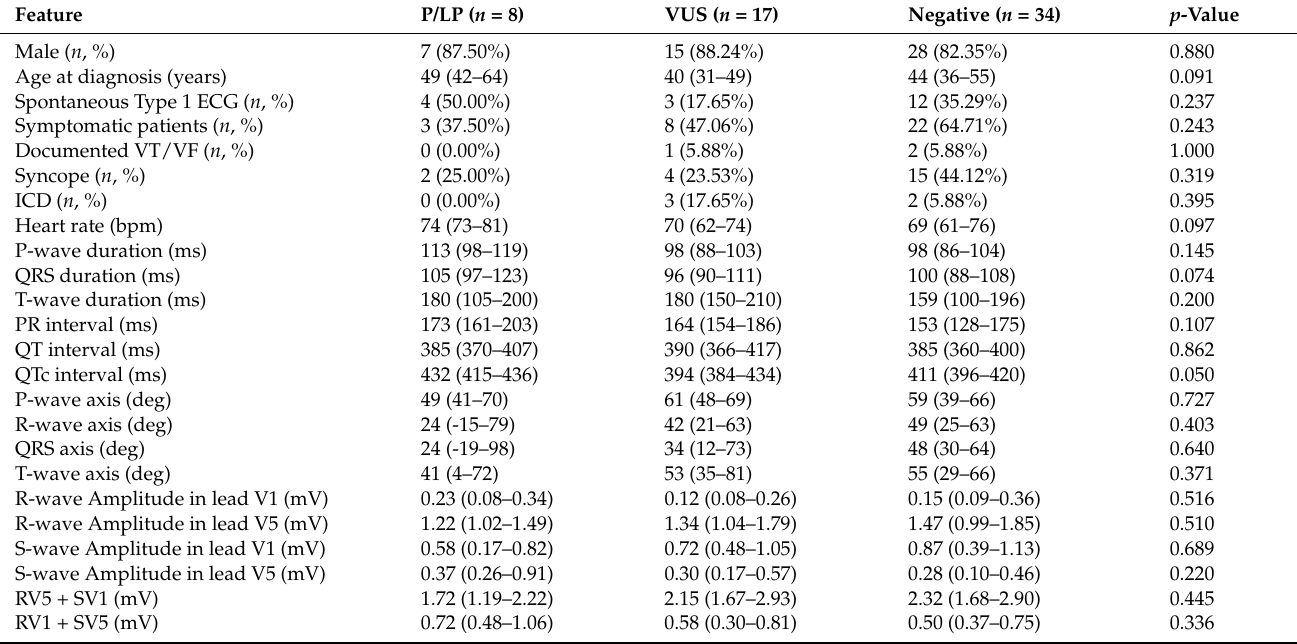
Table 3. Clinical and ECG characteristics of the included subjects classified by the mutation